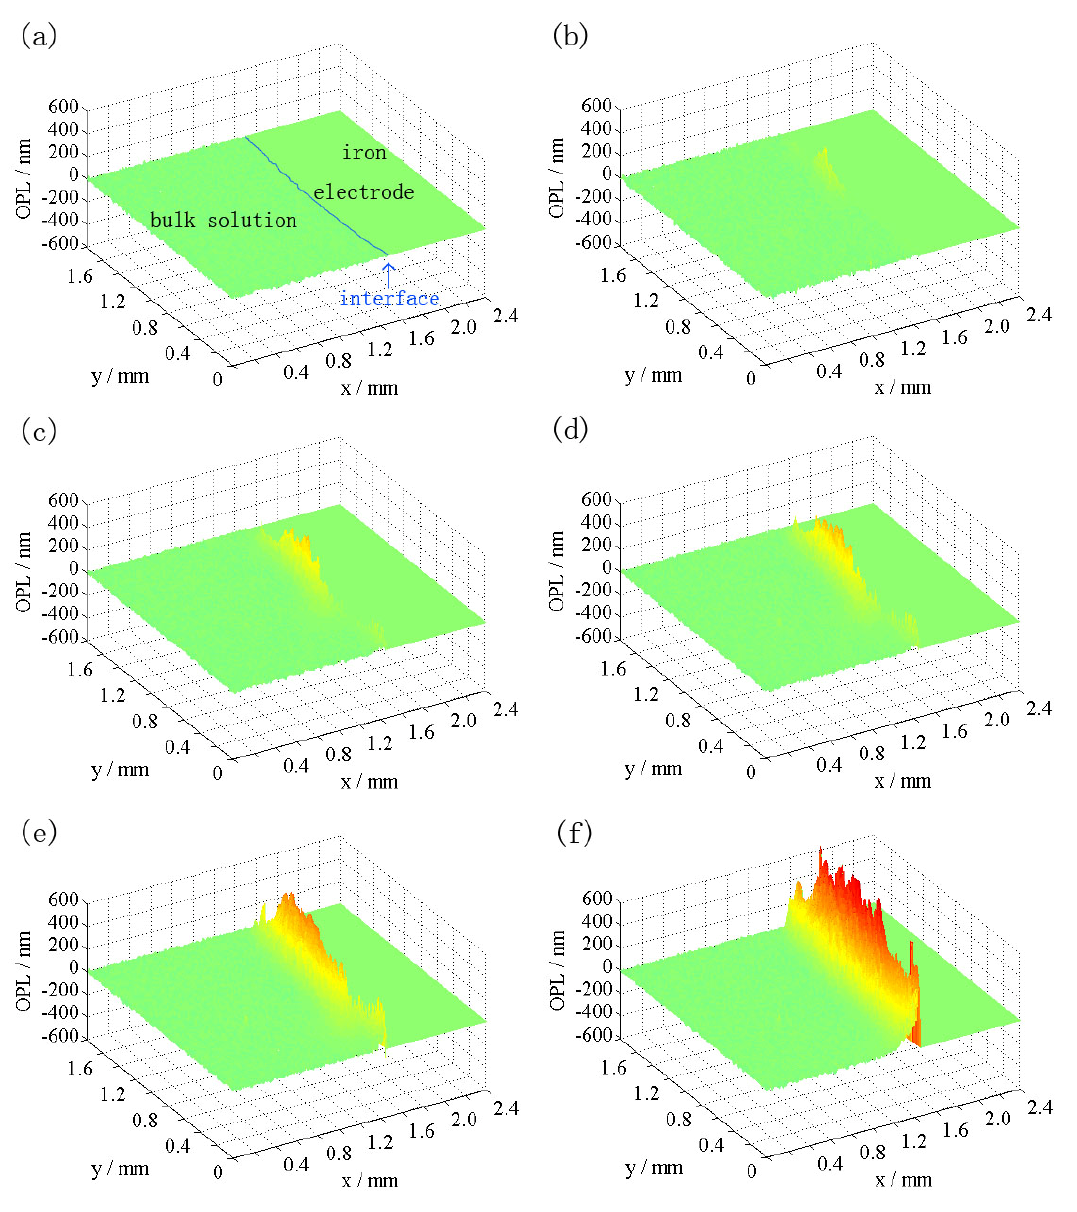
Figure 7. The distributions of the OPL difference at different times in comparison with the initial time during the process of the iron electrode in 0.5 M NaCl solution at 10 mV·s − 1